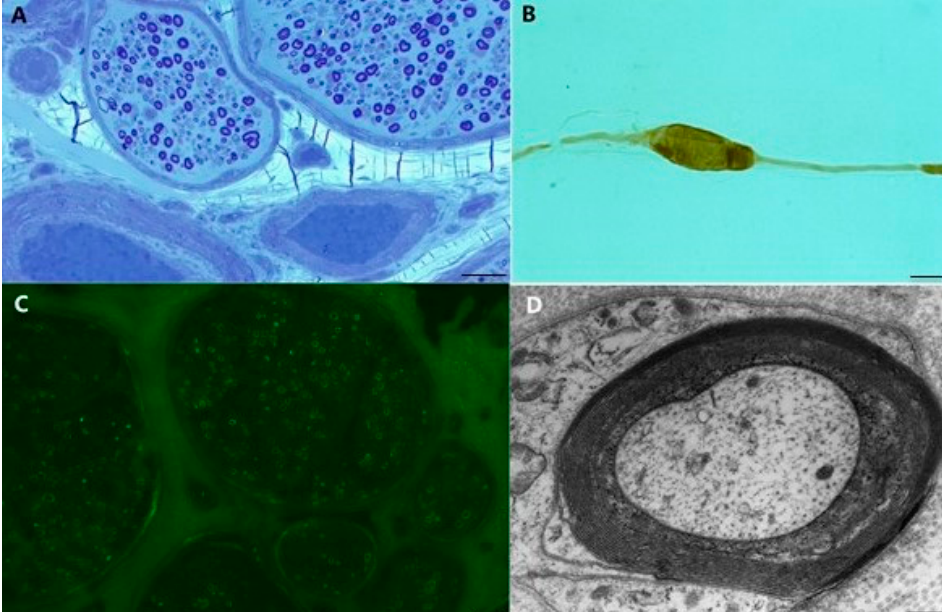
Figure 1. Sural nerve biopsy from anti-MAG antibody neuropathy. ( A ) Slight reduction of myelinated fibers is observed; rare fibers are surrounded by disproportionately thin myelin sheaths compared to axonal diameter and a few fibers show axonal degeneration. A myelinated fiber with intramyelinic oedema is evident. (semithin section, toluidine blue; original magnification 20×; bar 50 μ m); ( B ) Teased fiber showing a focal pale swelling in the remyelinating internode (original magnification 40×; bar 25 μ m); ( C ) Direct Immunofluorescent studies on frozen sections shows the presence of IgM deposition on the myelin sheaths of several fibers (original magnification 20×; bar 50 μ m); ( D ) Electron micrograph of a transverse section through a nerve fiber with widening of myelin lamellae as a result of separation along intraperiod line. (original magnification 12,000×; bar 1 μ m).